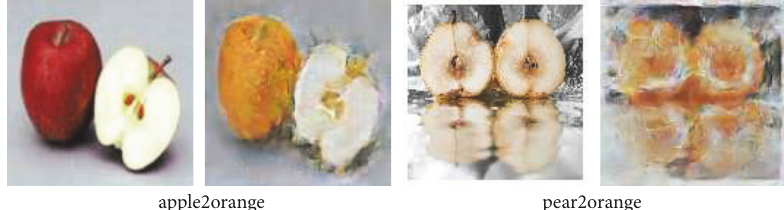
Figure 8: The failure of image translation in the testing